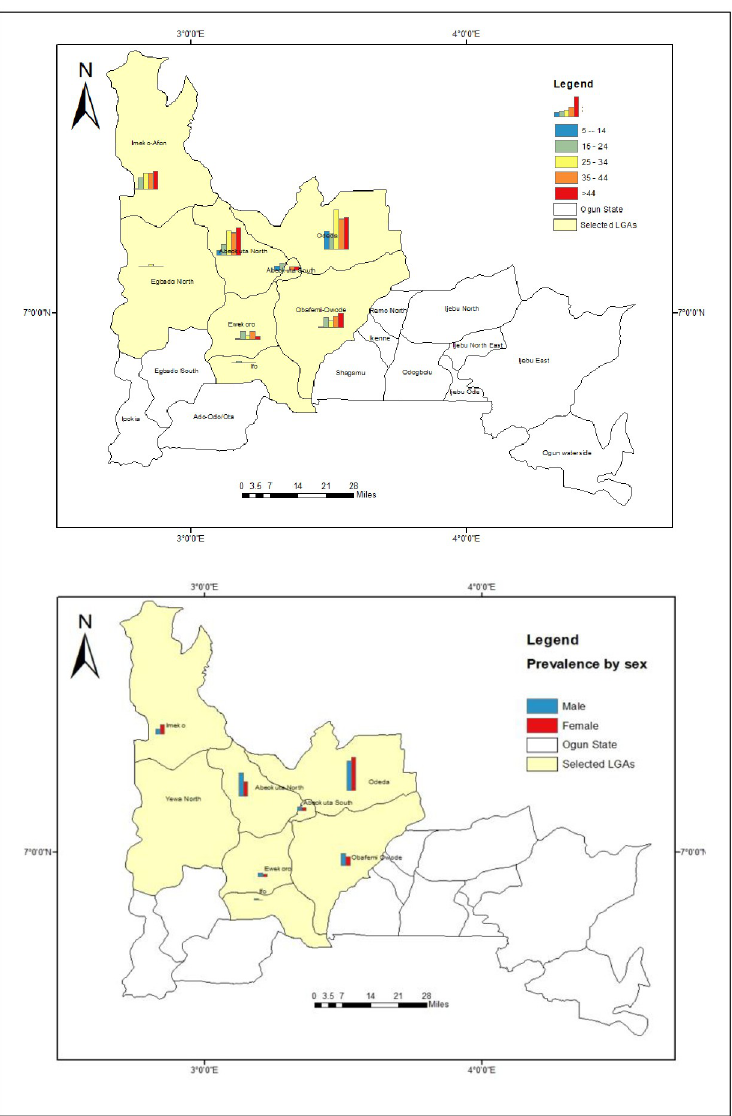
Fig 3. Geospatial distribution of onchocerciasis by age and sex in the selected LGAs. This figure was created by the authors in R programming software (R version 4.1.2, Vienna, Austria). Available at https://www.R-project.org/. The Nigerian shapefile was obtained from World BankDataCatalog (https://data.humdata.org/dataset/geoboundaries- admin-boundaries-for-nigeria) an Open license standardized resource of boundaries (i.e., state, county) for every country in the